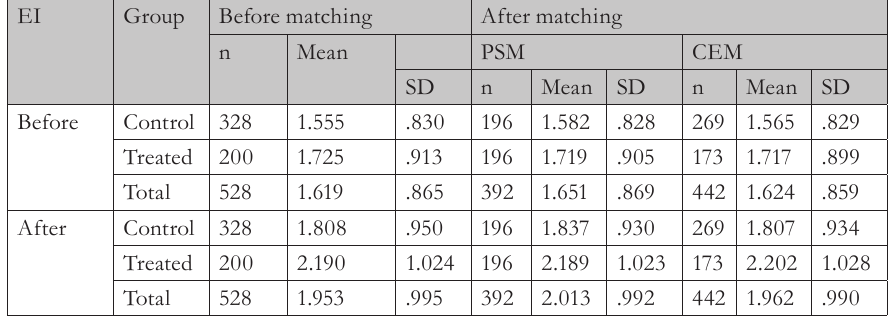
Tab. 3 – Mean and standard deviation of EI for control and treated groups Source: own